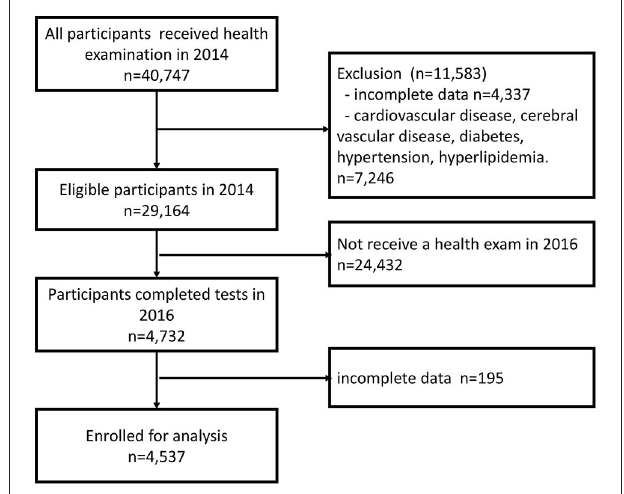
FIGURE 1 | Flow-chart of inclusion and exclusion